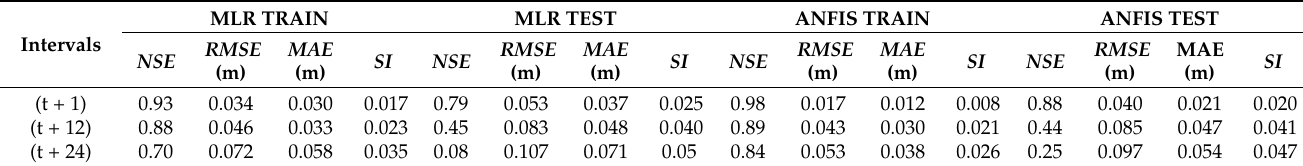
Table 3. Statistical performance of the SC2 -based MLR, ANFIS